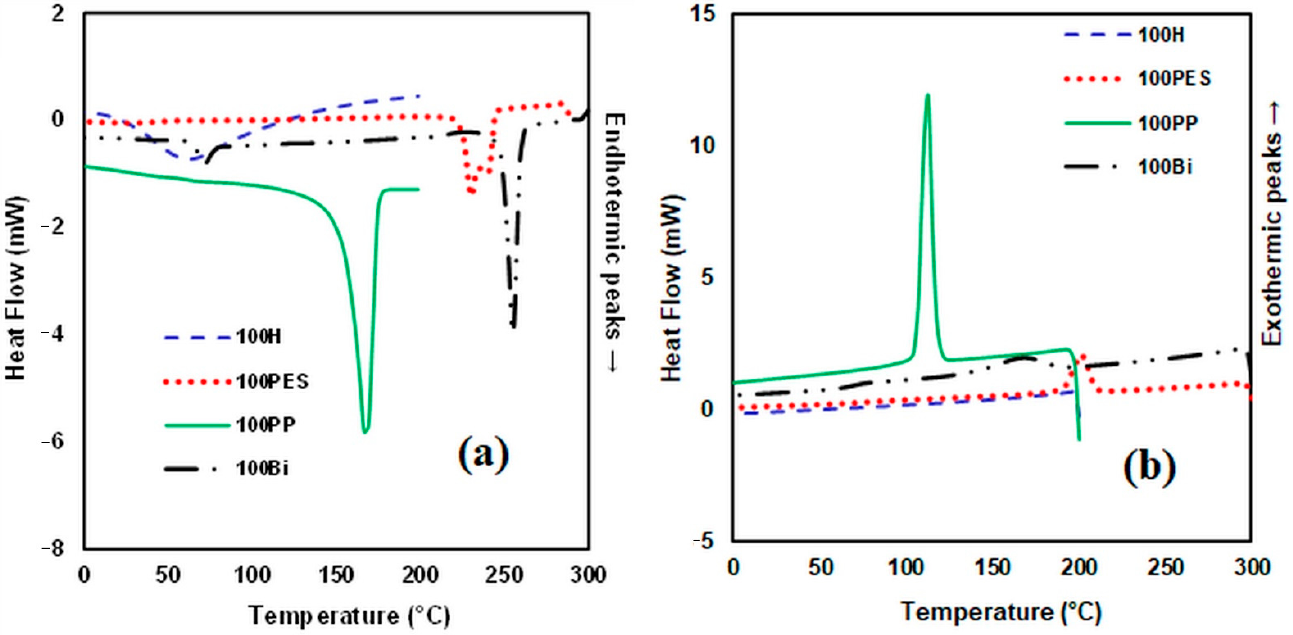
Figure 7. DSC curves heating process ( a ) and DSC curves cooling process ( b ) for hemp fibres and various matrices.